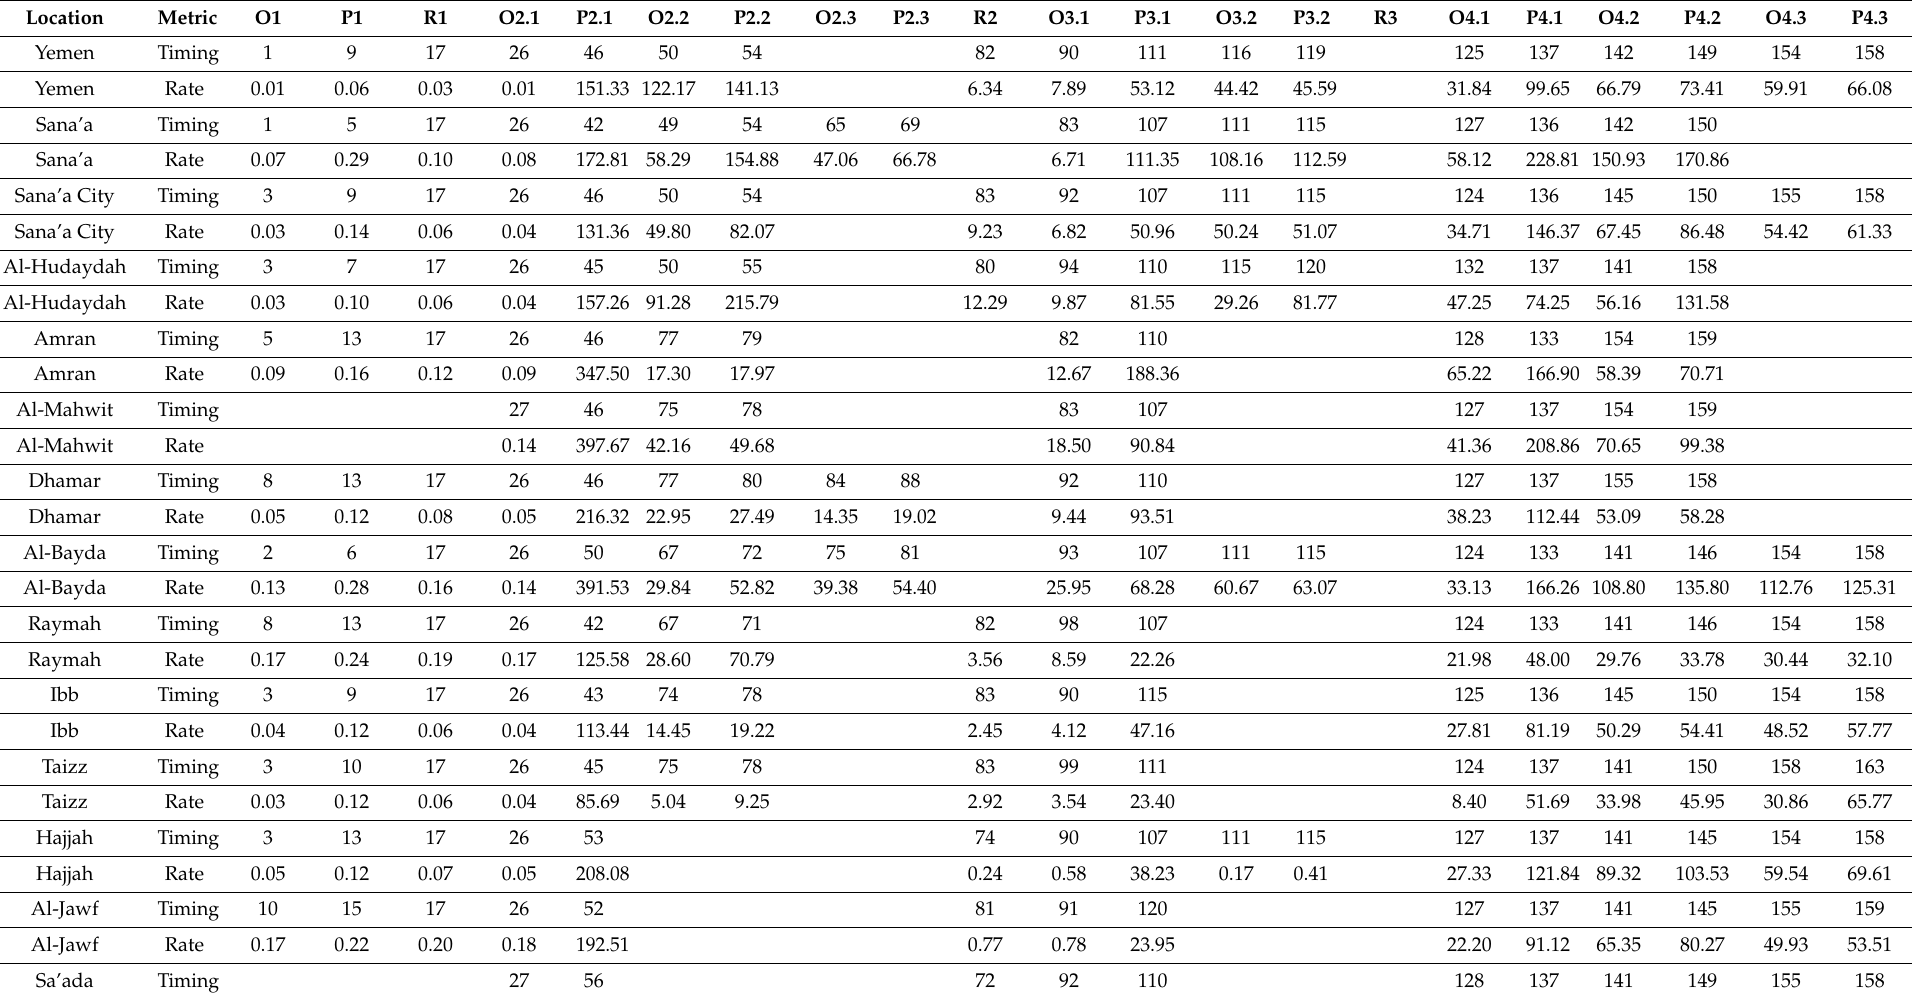
Table 1. Timing and magnitude of smoothed rate values at the onset, peak, and resolution critical points for four outbreak waves in Yemen from Week 36